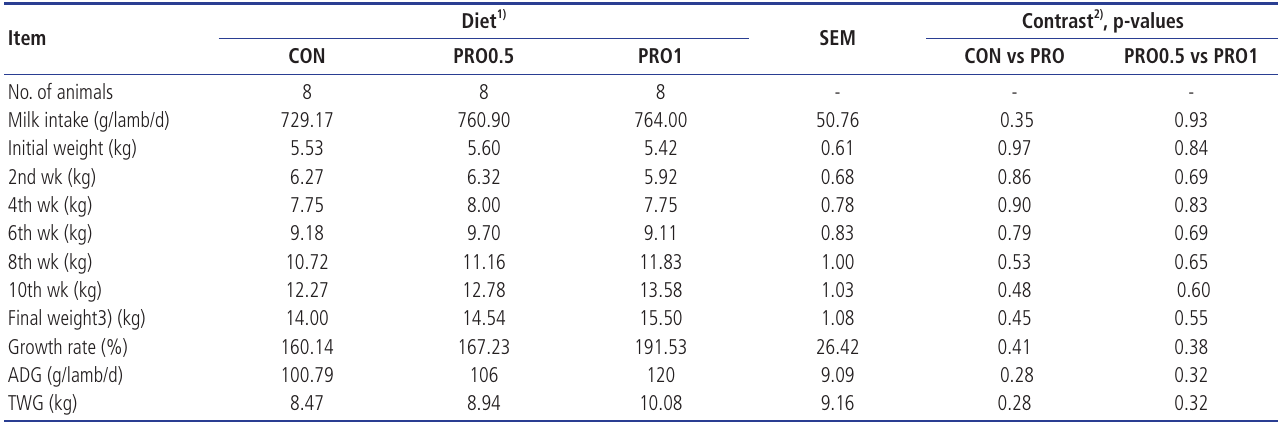
Table 3. Effect of probiotic (PRO) supplementation on growth performance, average daily gain, and total weight gain of lambs during pre-weaning period Item